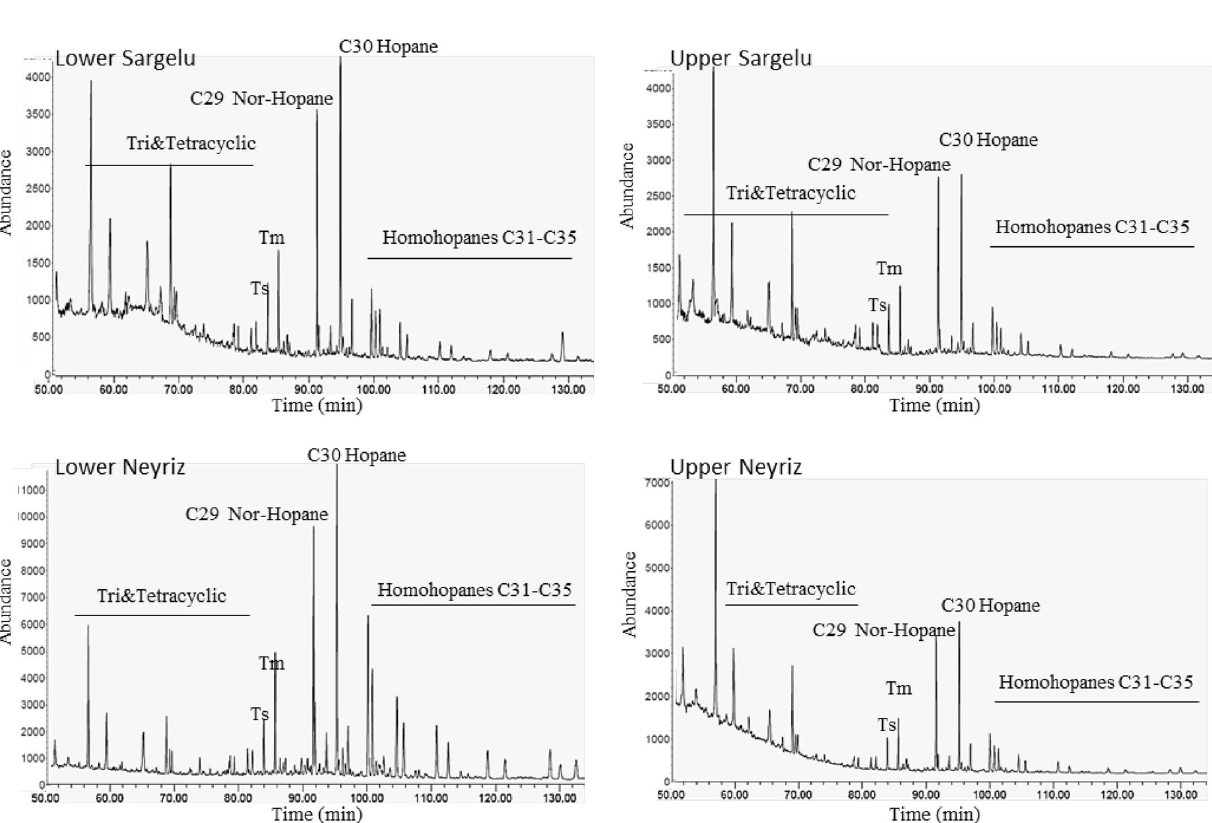
Fig. 9 Mass chromatograms ( m / z 191) of the studied rock samples showing the distribution of